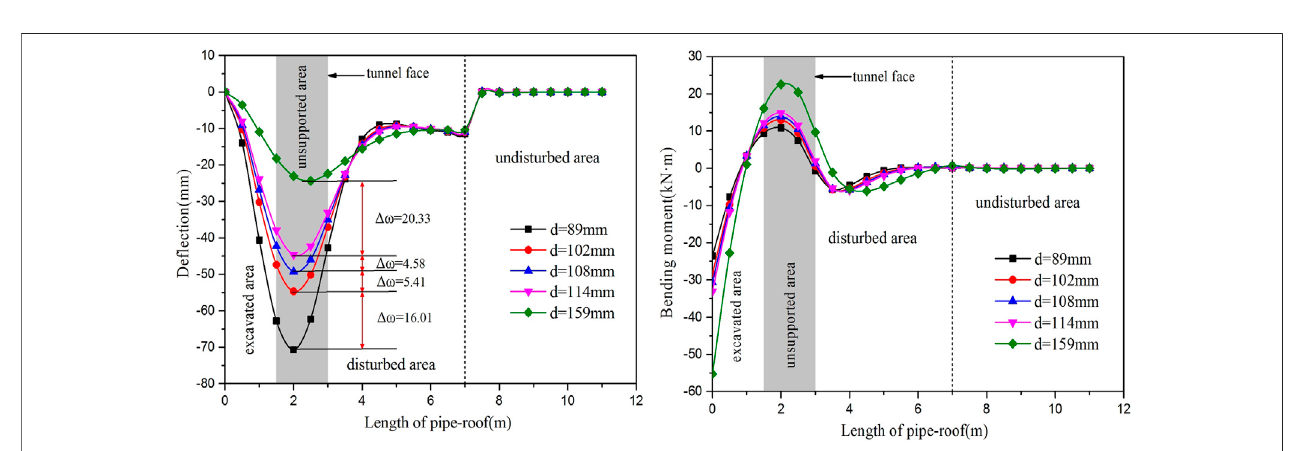
FIGURE 12 | The relation between diameter and de fl ection and bending